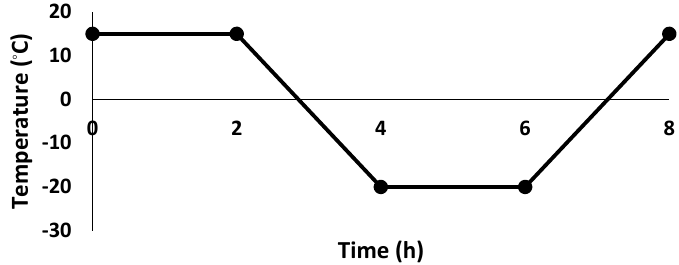
Figure 3. Adopted protocol for temperature variations per one cycle in freeze/thaw test .